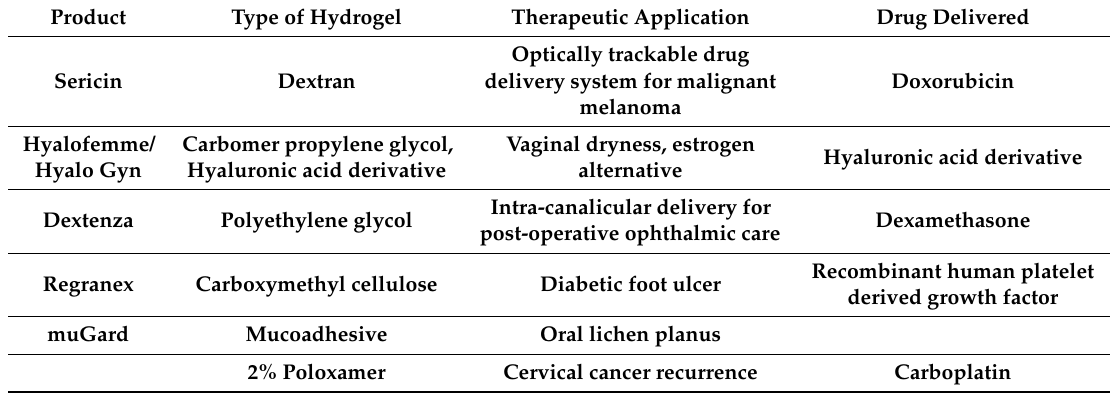
Table 2. Examples of hydrogels translated to clinical use